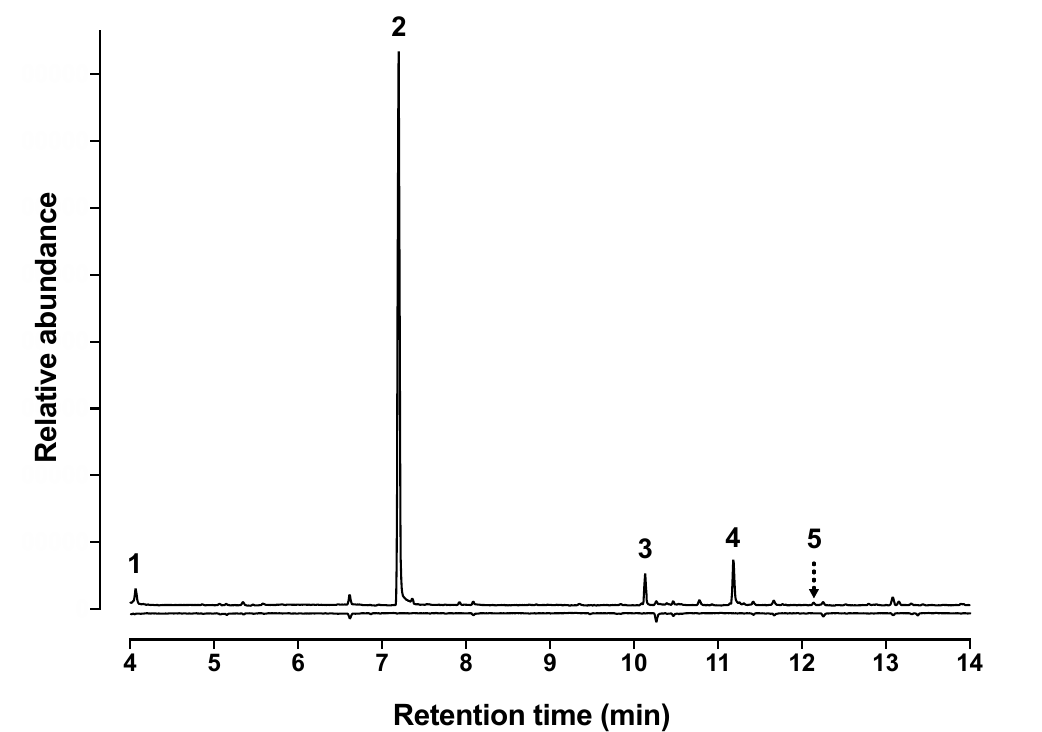
Figure 1. Representative total ion chromatograms of headspace volatile extracts from adult males (top trace) and females (bottom, inverted trace) of Euplatypus parallelus . Numbers on peaks represent the male-specific volatile compounds: 1 = 3-methyl-1-butanol; 2 = 1-hexanol; 3 = hexyl acetate; 4 = 1-octanol; and 5 = geraniol.